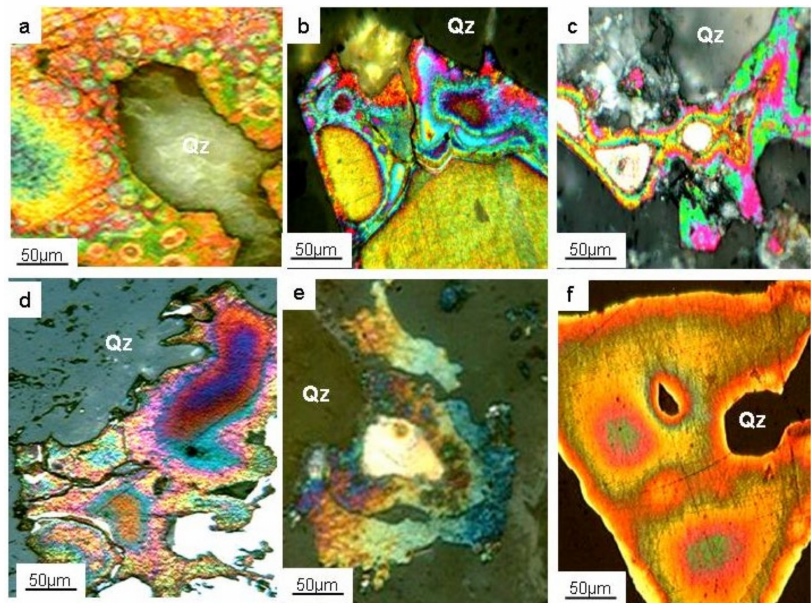
Figure 12. Internal structures of native gold from ores of gold–silver adularia GIT deposits: ( a ) spotted (Kubaka); ( b ) clear zonal (Dalnee); ( c ) zonal (Olcha); ( d ) zonal with a break in the boundaries (Kupol); ( e ) zonal (Burgali); ( f ) zonal